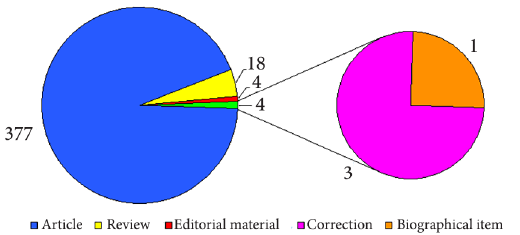
Figure 1. Types of the JEELM publications